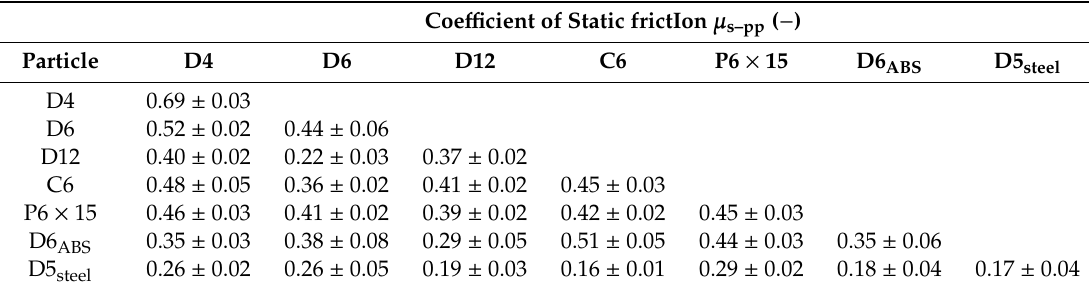
Table 9. Results of particle-particle static friction coe ffi cients values.